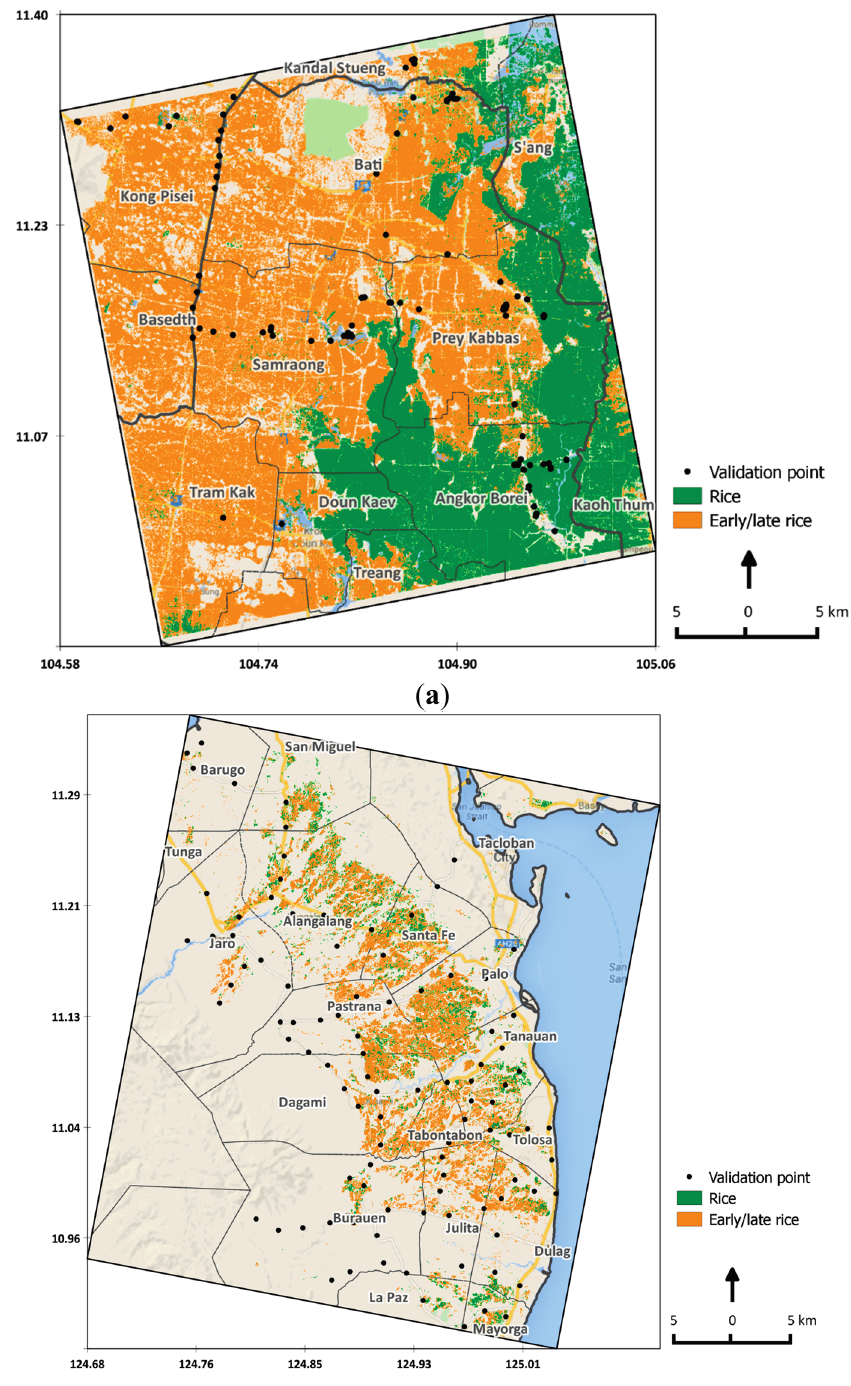
Figure 5. ( a ) Rice area map for Site 1, Takeo, Cambodia; ( b ) rice area map for Site 2, Leyte East, Philippines; ( c ) rice area map for Site 3, Leyte West, Philippines; ( d ) Rice area map for Site 4, Agusan del Norte, Philippines; ( e ) rice area map for Site 5, Soc Trang, Vietnam; ( f ) rice area map for Site 6, Nam Dinh, Vietnam; ( g ) rice area map for Site 7, Subang, Indonesia; ( h ) rice area map for Site 8, Cuddalore, India; ( i ) rice area map for Site 9, Thanjavur, India; ( j ) rice area map for Site 10, Sivaganga, India; ( k ) rice area map for Site 11, Muang Yang, Thailand; ( l ) rice area map for Site 12, Suphan Buri, Thailand; ( m ) rice area map for Site 13, Nueva Ecija,